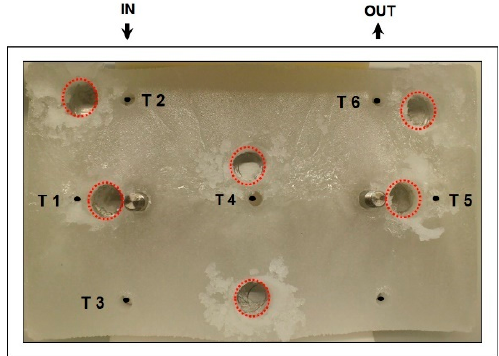
Figure 2. Frozen sample block after freezing cycle. The dots represent the temperature probes (compare to Figure 1b) including legend T 1 to T 6 including temperature measurement at the inlet and the outlet (IN and OUT). Red dotted circles represent the drilling holes for spatially resolved sampling.